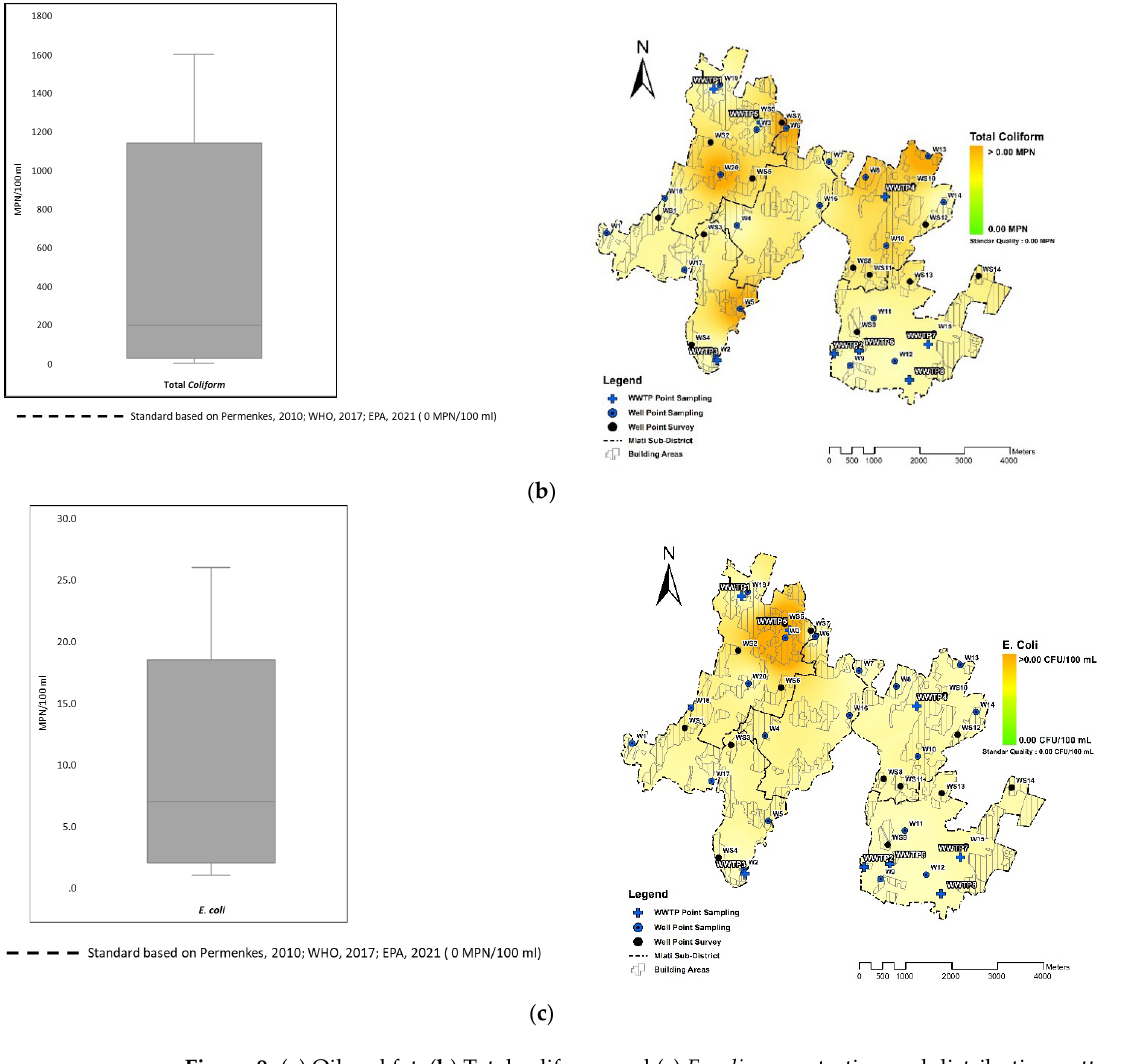
Figure 9. ( a ) Oil and fat, ( b ) Total coliform, and ( c ) E. coli concentration and distribution pattern.